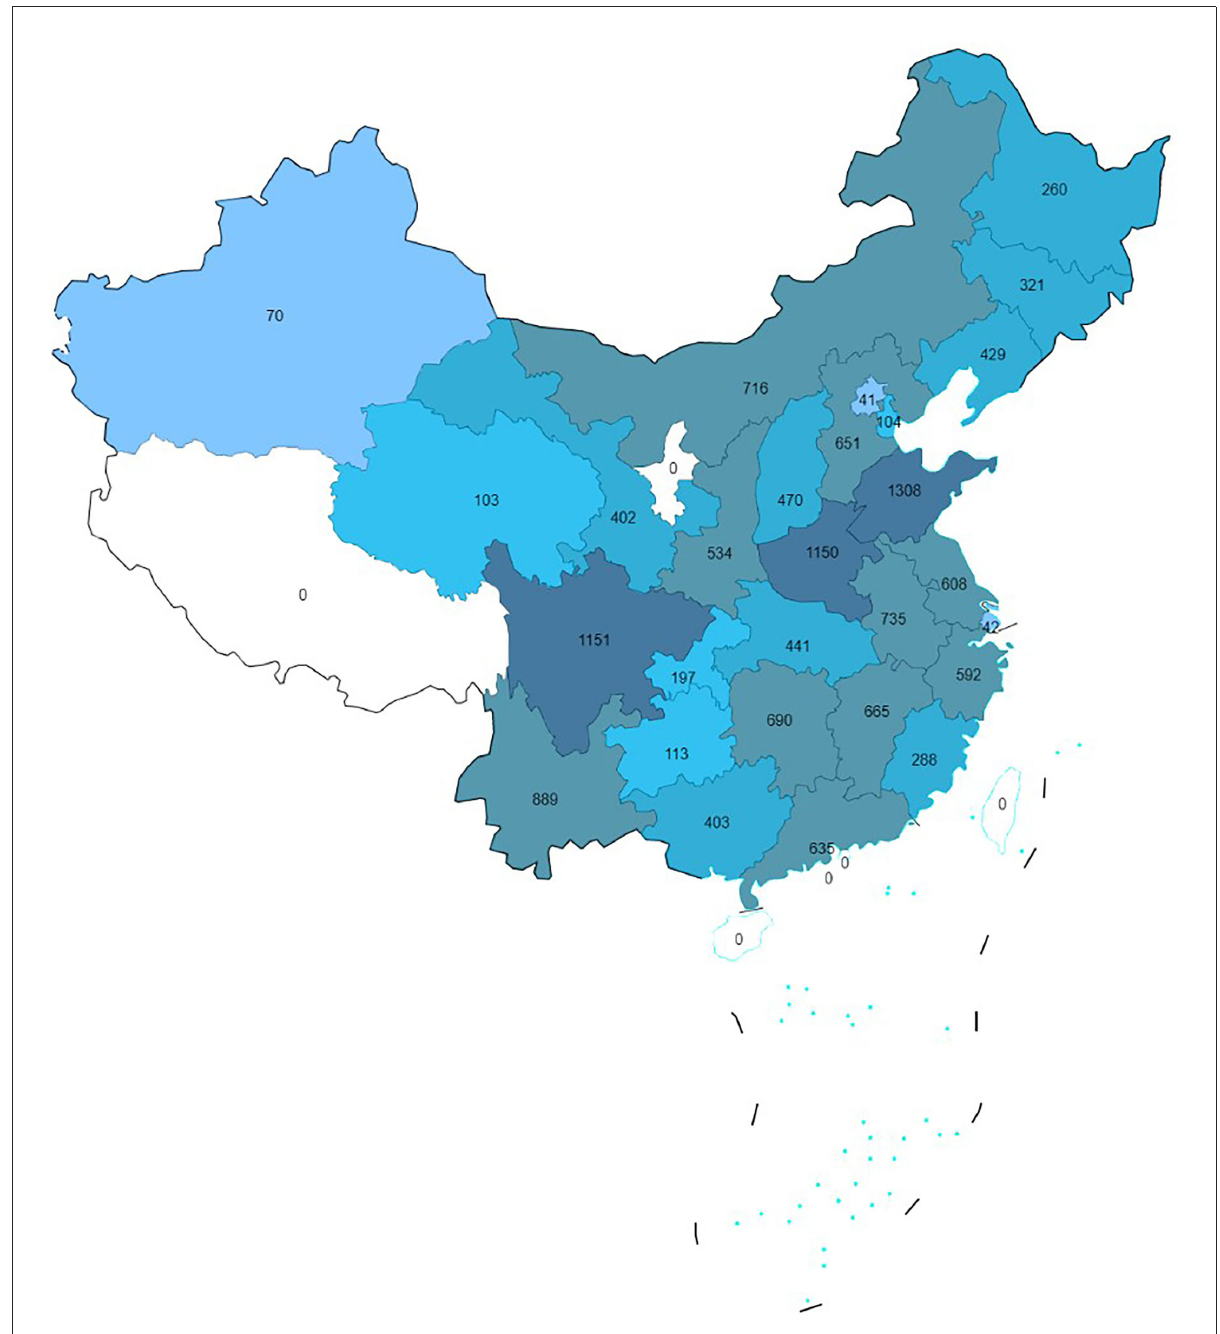
FIGURE2 Geographical distribution of the participants.